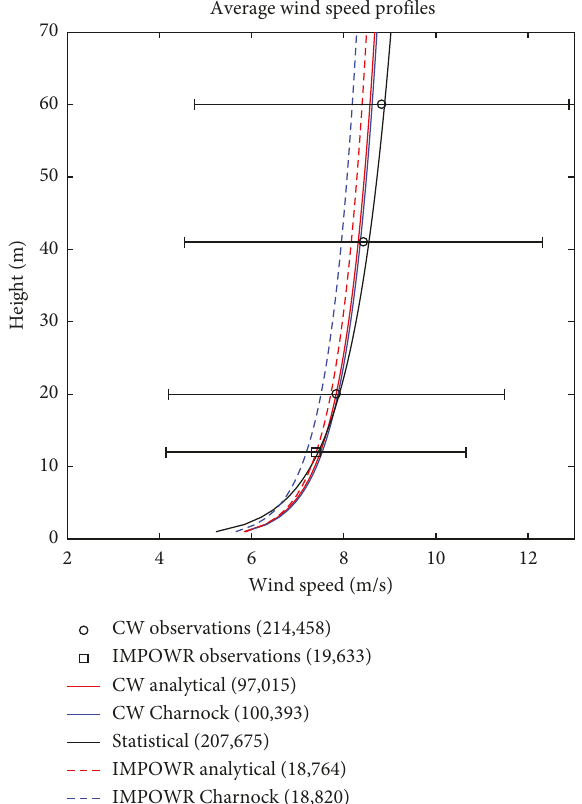
Figure 6: Average wind speed profiles calculated with z obtained with the three methods (Charnock, analytical, and sta- tistical, in blue, red, and green) for both the CW Historical and IMPOWR campaigns (solid and dashed lines). The observations are displayed with solid